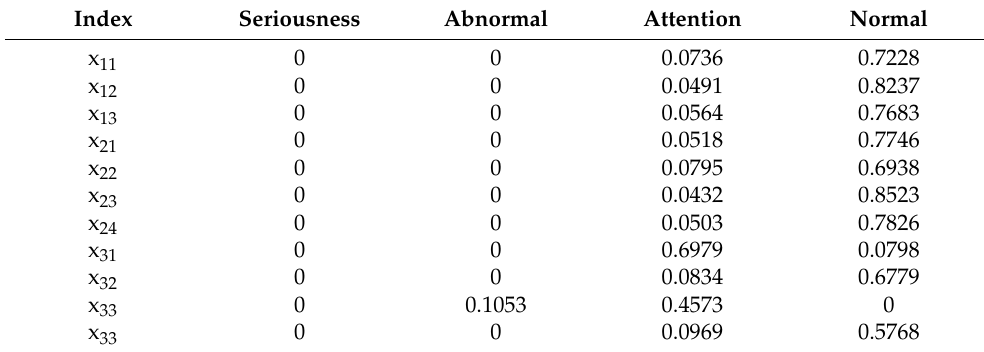
Table 3. Index membership of base layer.